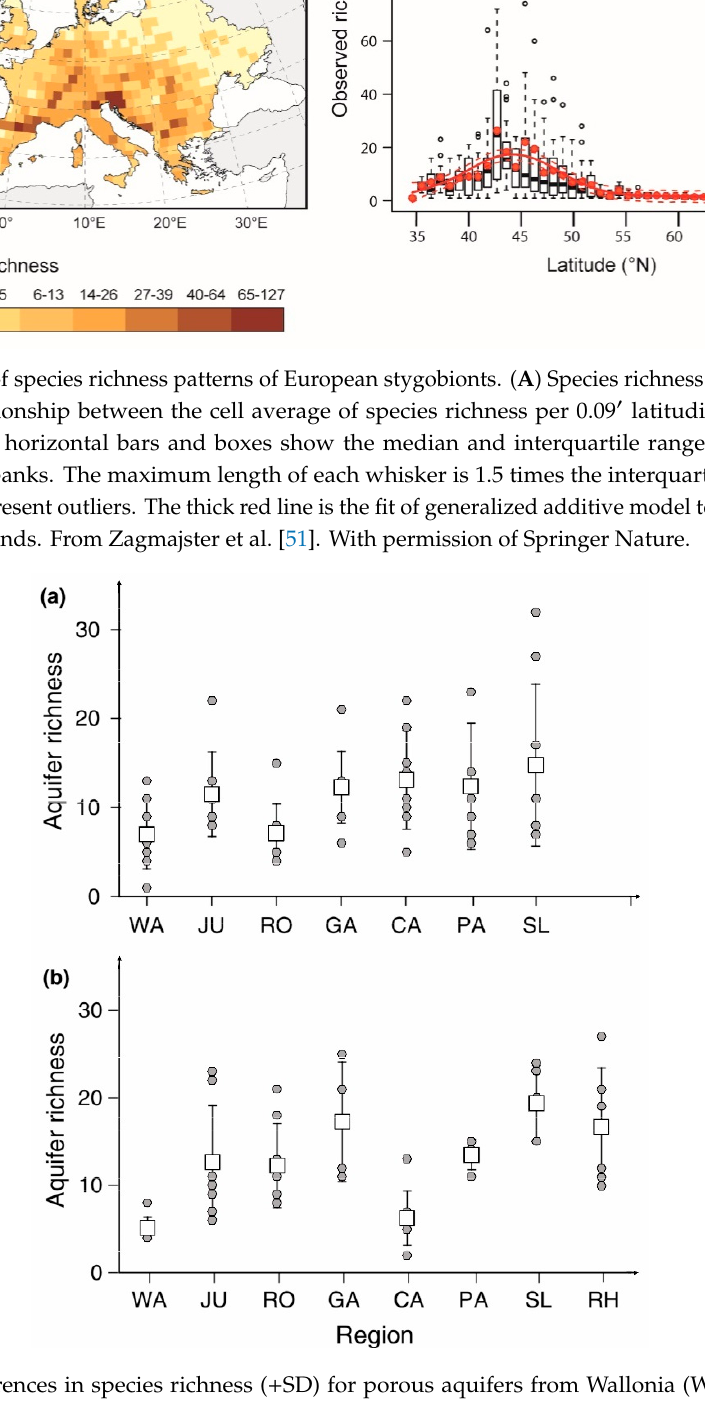
latitudinal bands. From Zagmajster et al. [51]. With permission of Springer Nature.